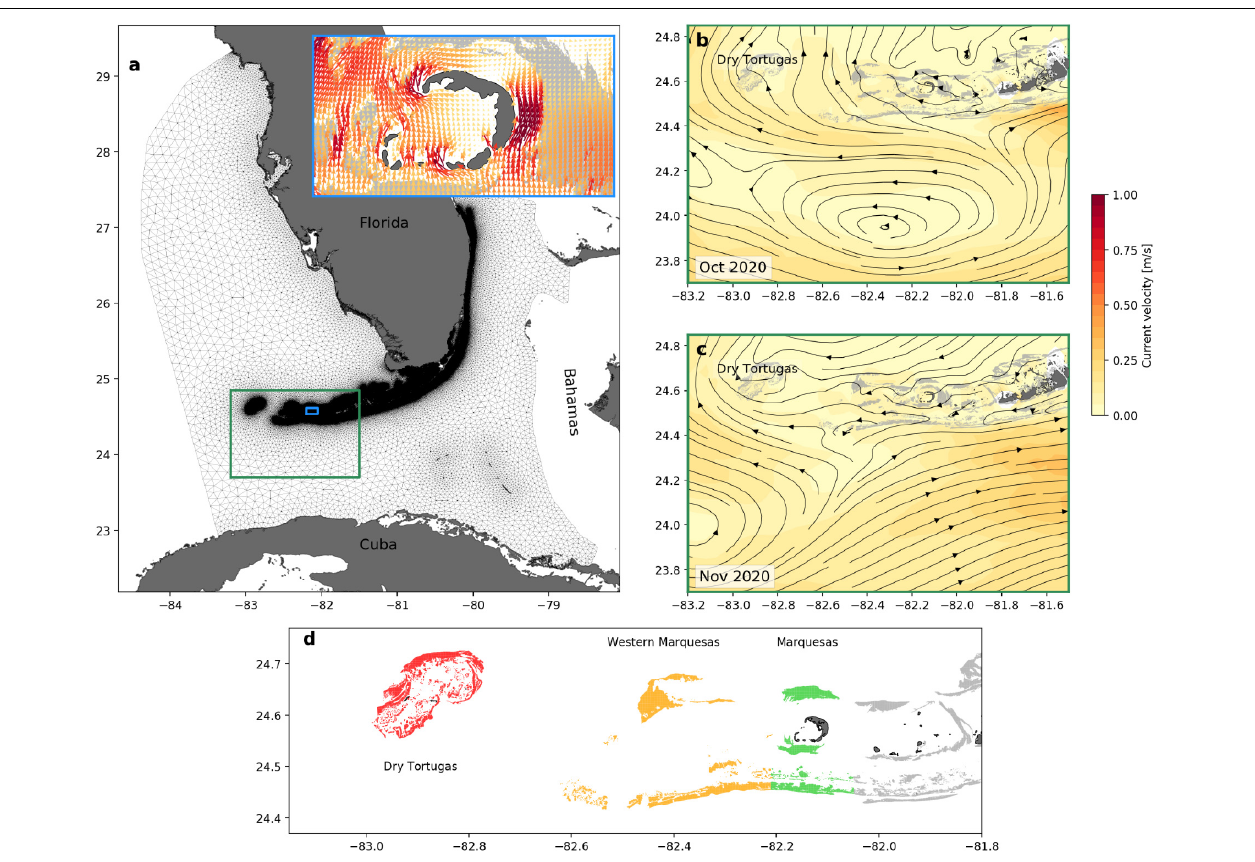
FIGURE 1 | (a) Mesh of the computational domain and close-up view of the instantaneous currents on November 15 2020 at 12:00 in the Marquesas (inset), (b) close-up view of the monthly-averaged circulation between the Marquesas and the DRTO in October 2020, and (c) November 2020. (d) Reefs of the areas of the DRTO, the Western Marquesas and the Marquesas, as defined in this study. Land is shown in dark gray and reefs in light gray, except in panel (d) where reefs from the Marquesas, the Western Marquesas and the DRTO are, respectively, shown in green, yellow and red. Streamlines indicate the presence of the Tortugas gyre in October 2020, which leads to northward currents between the Marquesas and the DRTO. In November, the gyre left its static location to transit through the Straits of Florida and currents between the Marquesas and DRTO became